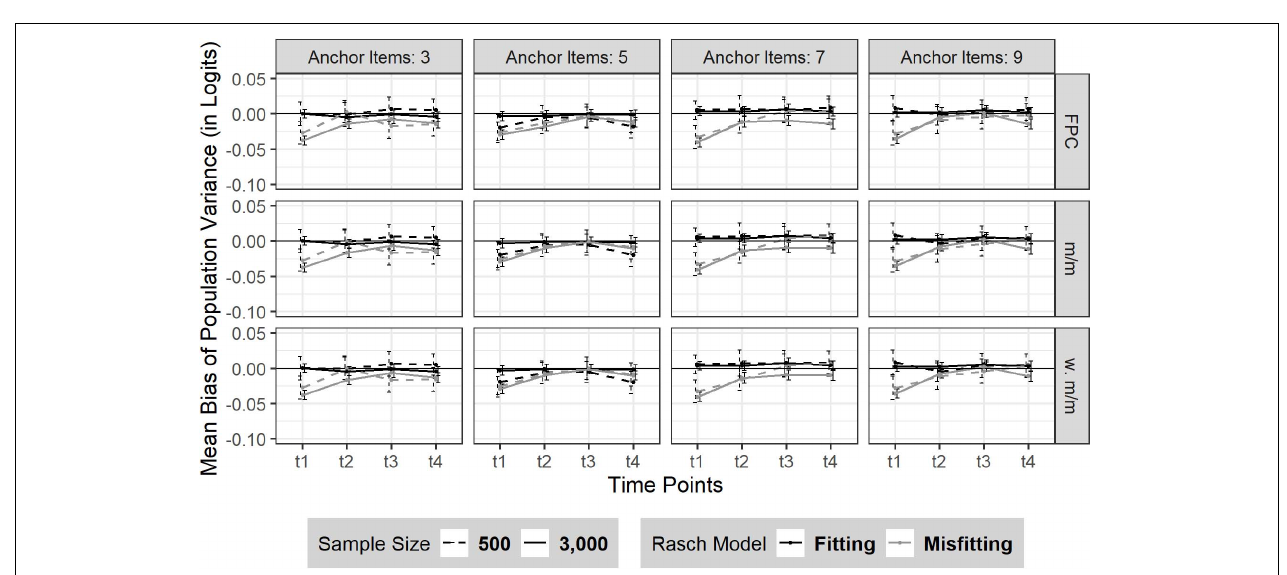
FIGURE 2 | RMSE of sample mean over three time points (t 2 –t 4 ). The figure is split by the three linking methods and the experimental factors number of anchor items, sample size and Rasch model-data fit. FPC = fixed parameter calibration, Mean/Mean = mean/mean linking, w. Mean/Mean = weighted Mean/Mean. 95% confidence intervals are